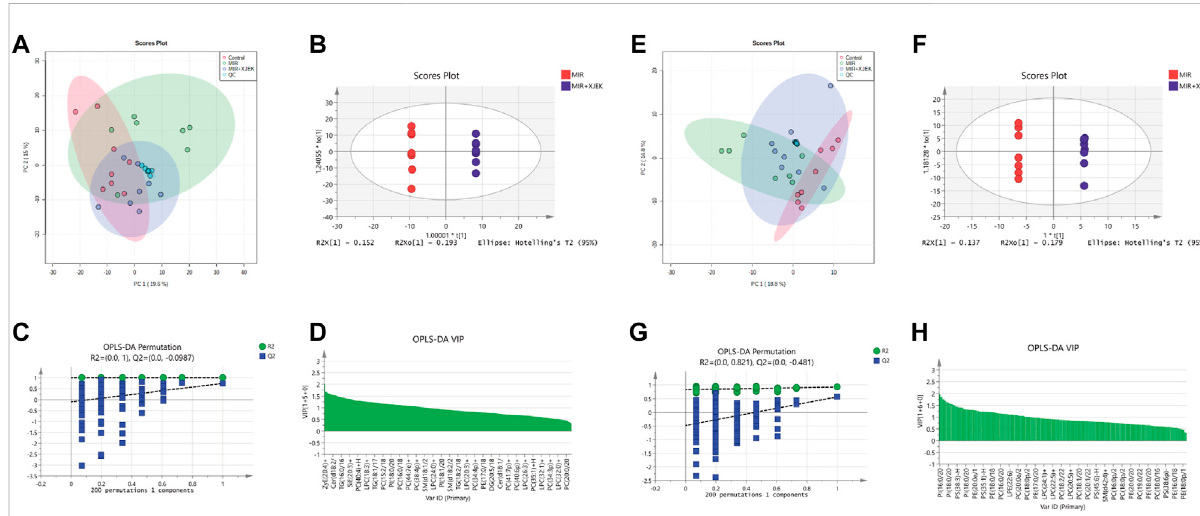
FIGURE 5 Serum lipid metabolic pro fi les. Serum lipid metabolic pro fi les were analyzed in both positive (A – D) and negative (E – H) model, respectively. (A – E) PCA analysis of lipid contents. (B – F) OPLS-DA analysis between MIR group and XJEK group. (C – G) Permutation test of OPLS-DA model. R2 represents the goodness of fi t, and Q2 indicates the predictability of the models. (D – H) A variable importance of projection (VIP) plot with jack- knifed con fi dence intervals.